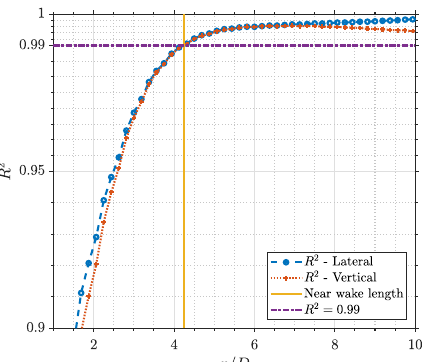
Figure 3. An example of the near-wake length calculation method for Case T5. The same analysis was performed for all the cases in Table 1 to determine the near-wake length, and is not reported here for